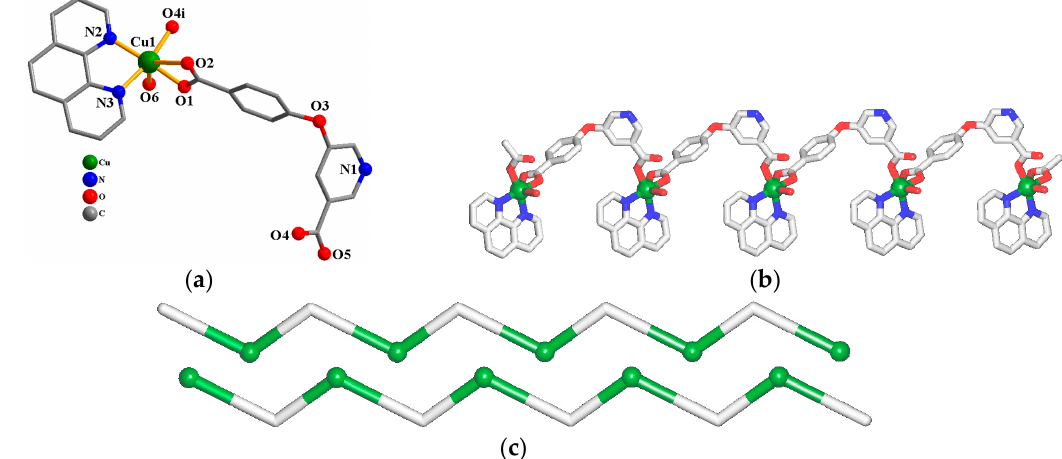
Figure 1. Structural fragments of 1 . ( a ) Coordination environment around the Cu(II) atom; H atoms are omitted for clarity. Symmetry code: i = x , y , z − 1. ( b ) Linear 1D coordination polymer chain (view along the a axis) . ( c ) Topological representation of two 1D chains showing a uninodal 2-connected underlying net with the 2C1 topology; color codes: 2-connected Cu nodes (green balls), centroids of 2-connected µ-cpna 2 − linkers (gray).